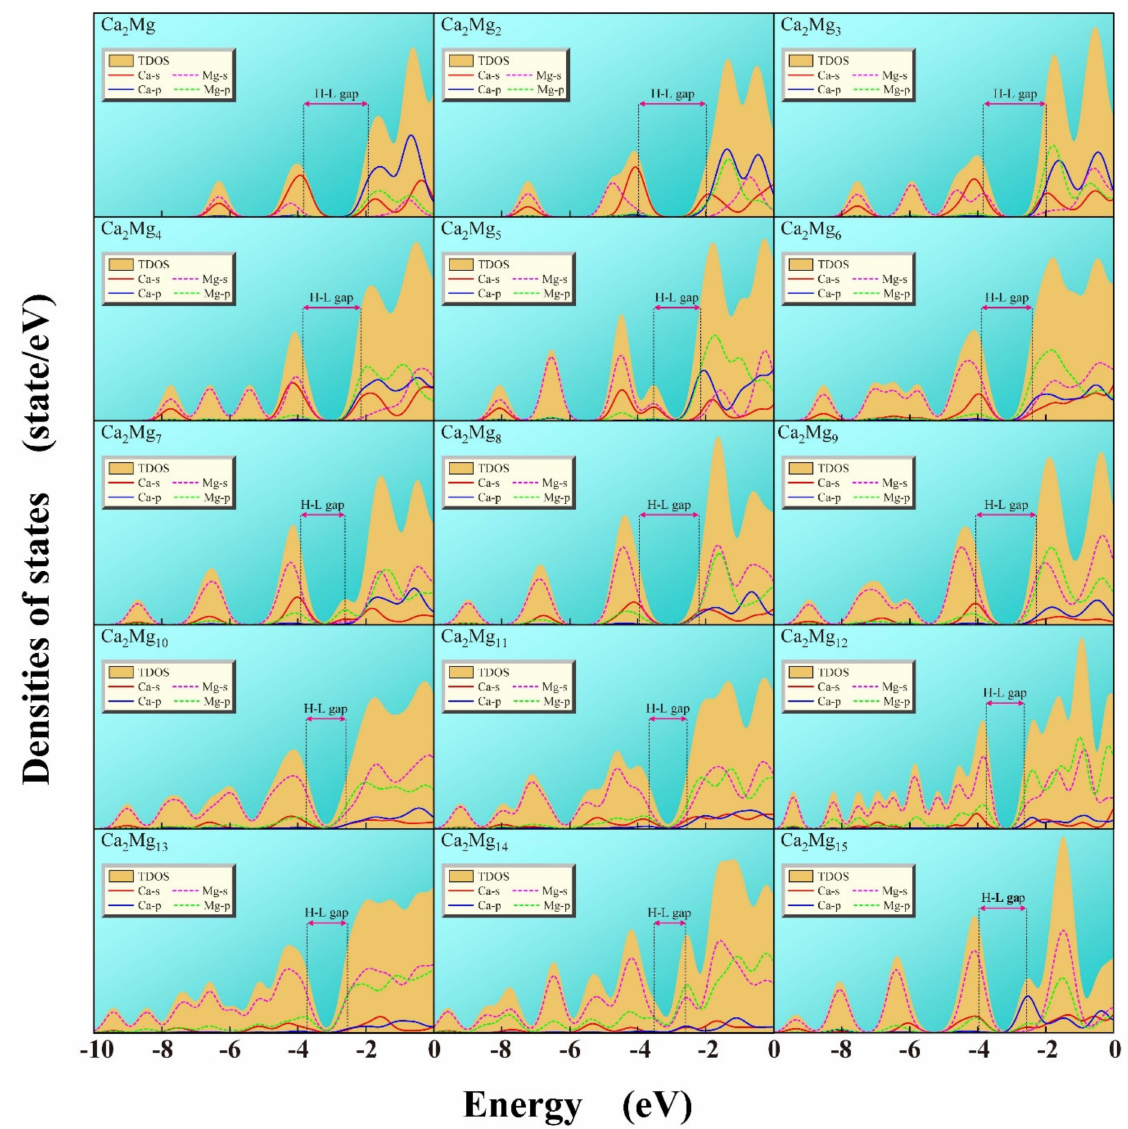
Figure 4. The calculated total densities of states (TDOS) and partial densities of states (PDOS) of Ca 2 Mg n ( n = 1–15)